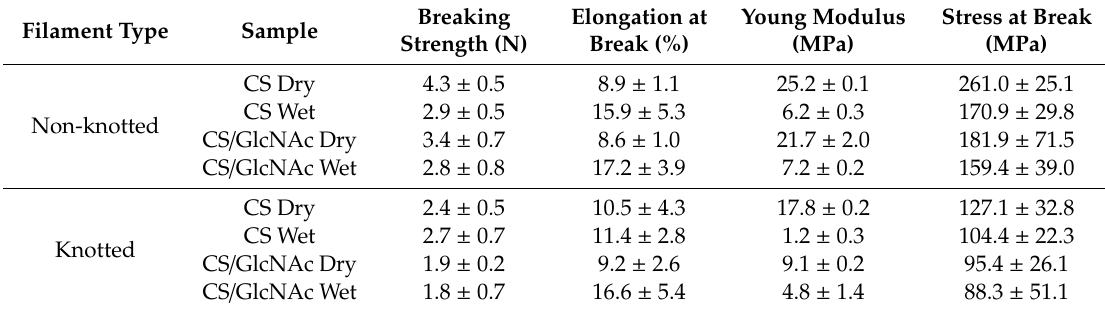
Table 2. Mechanical properties of the chitosan (CS) and N-acetyl-D-Glucosamine (GlcNAc)-loaded CS filaments—non-knotted and knotted—tested in a dry condition (dry) and under incubation conditions